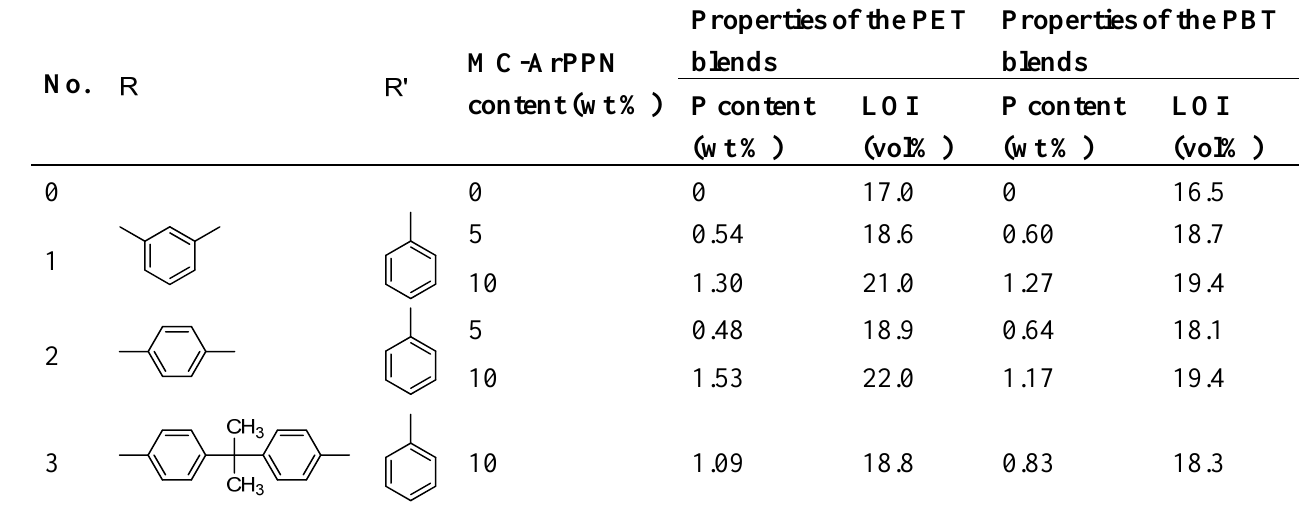
Table 1. Effect of structural variations on flame-retardant activity of MC-ArPPN in PET and PBT [9].